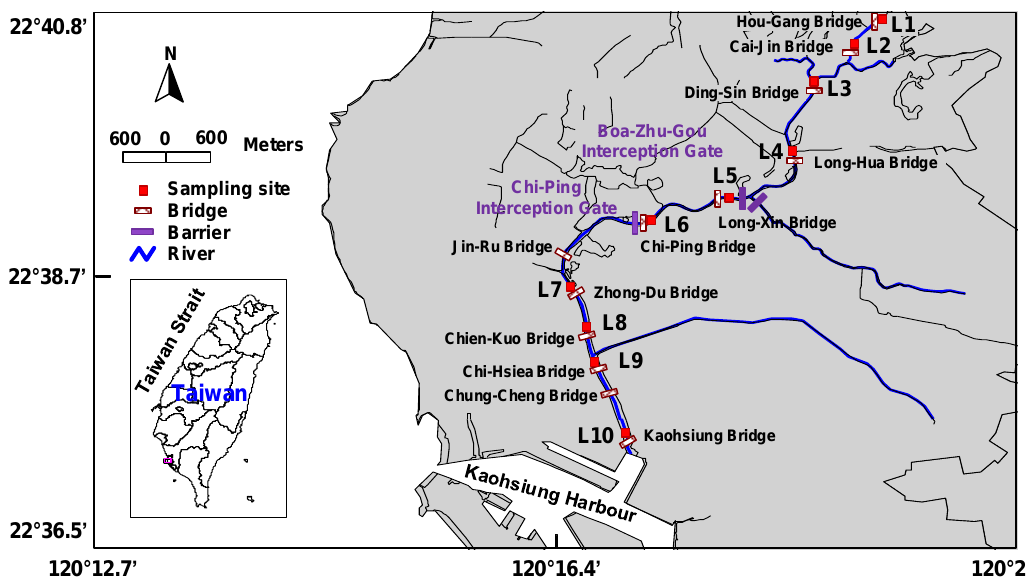
Figure 1. A map of the study area and the locations of the monitoring points.